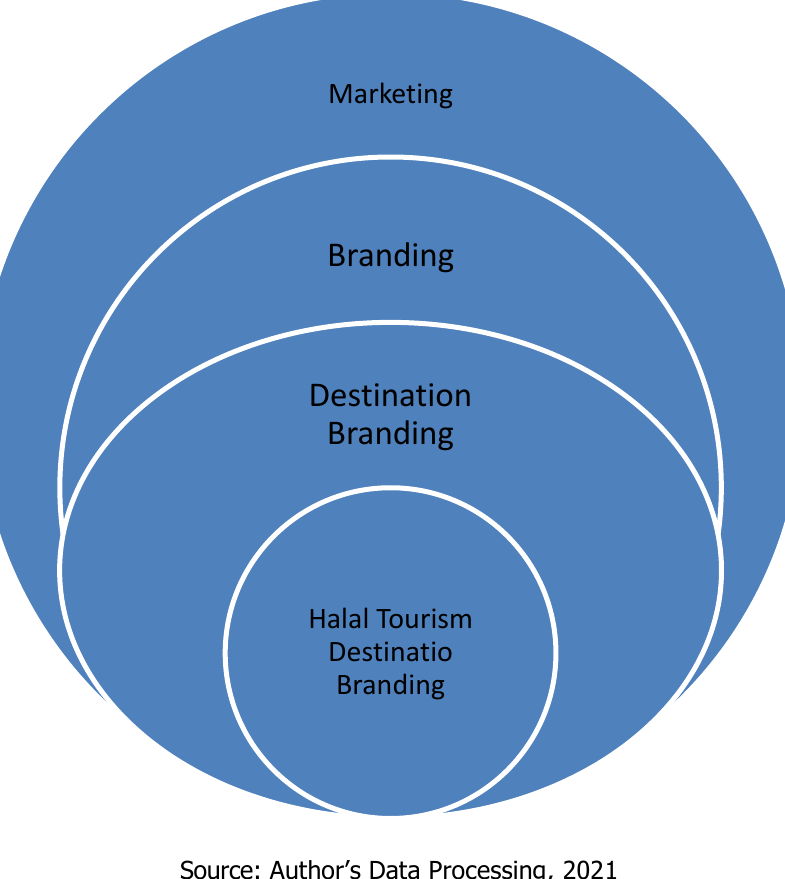
Figure 1. Theoretical Foundation of the